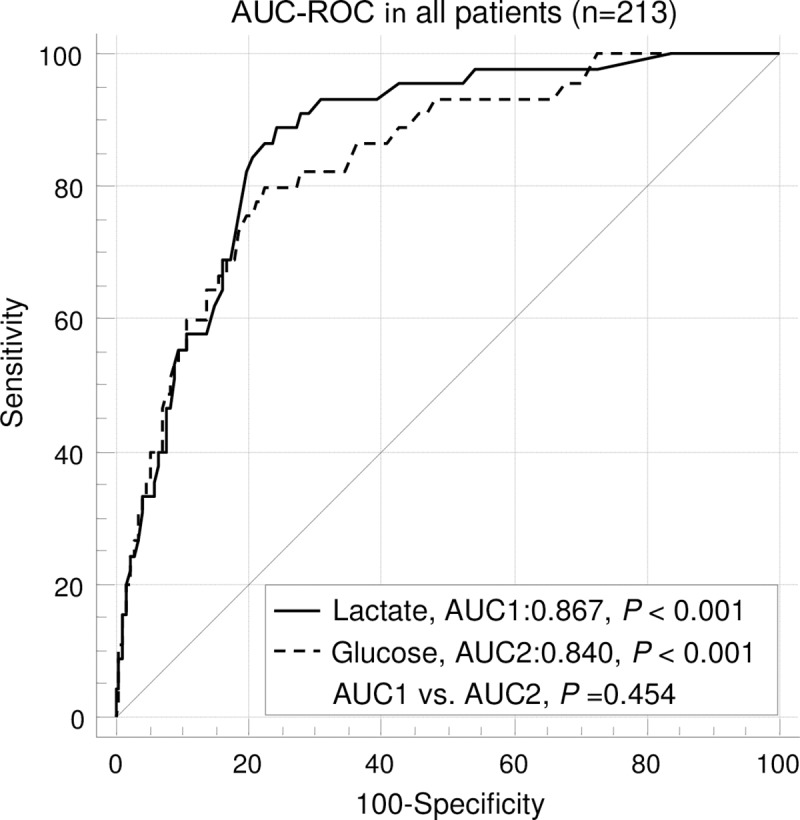
ROC curve analyses of mortality in all patients.The AUC of admission lactate was not significantly different from the AUC of admission glucose. AUC- area under the curve; GCS- glasgow coma scale; ROC- receiver operating characteristic.